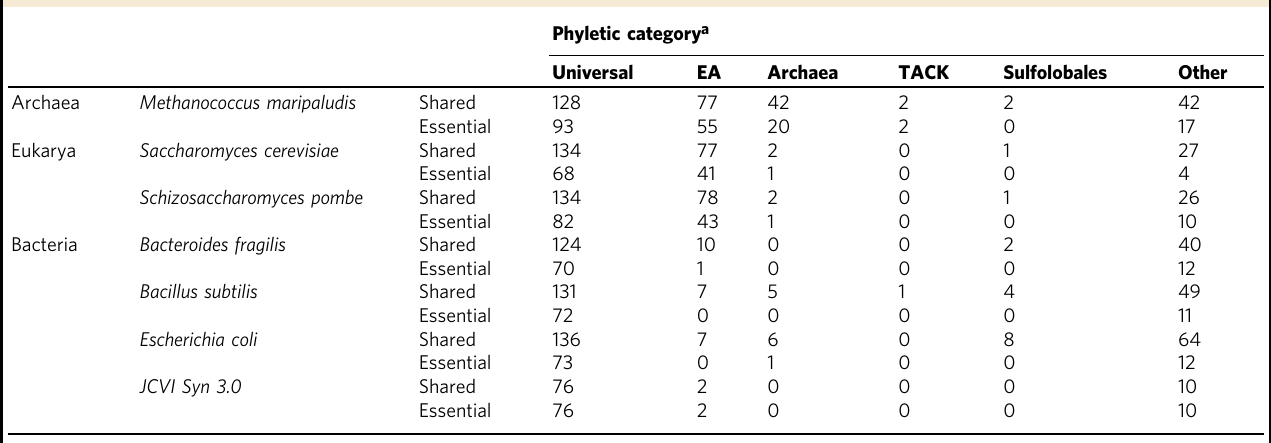
Table 1 Number of S. islandicus essential genes shared with seven model organisms